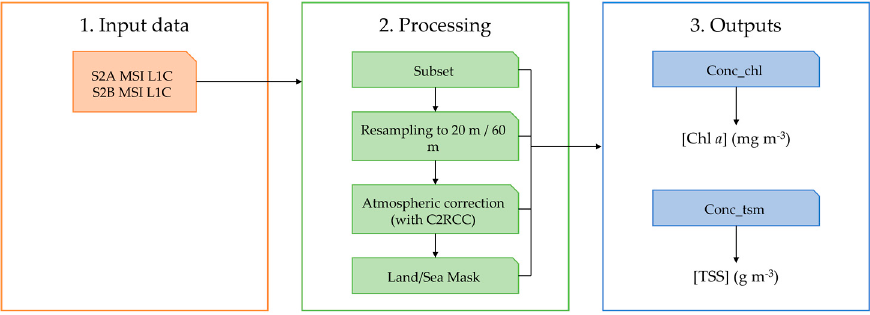
Figure 2. Schematic representation of the workflow used for image processing and output achievement.